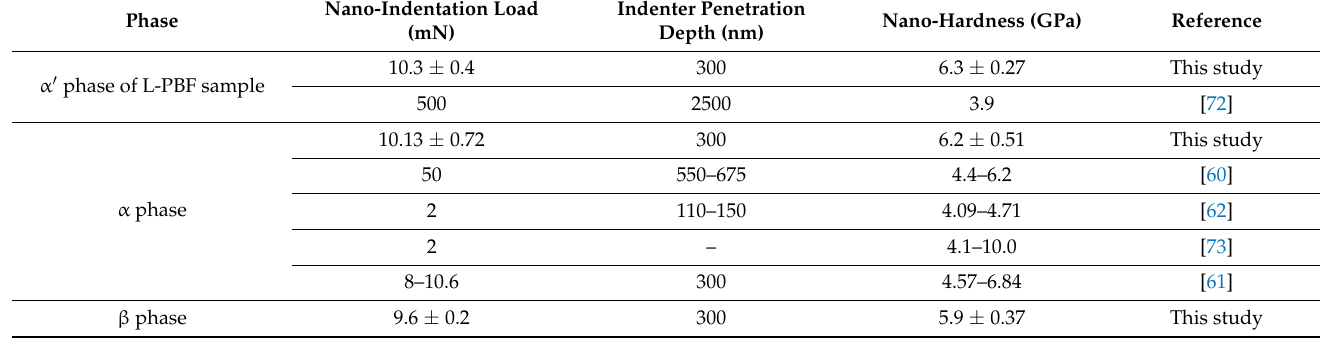
Table 4. Nano-hardness of α ’, α , and β in L-PBF and PM samples.